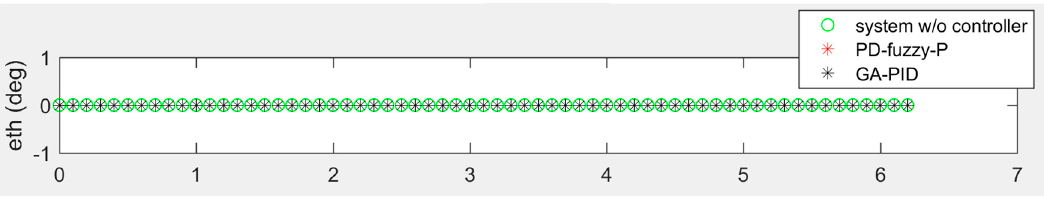
Figure 11. The error of the rotational motion of the rose shaped path in the global frame in meter.